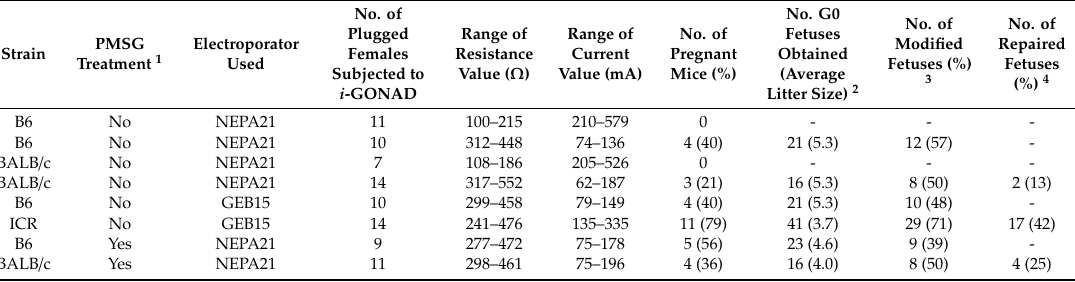
Table 1. Summary of i -GONAD using two electroporators, NEPA21 and